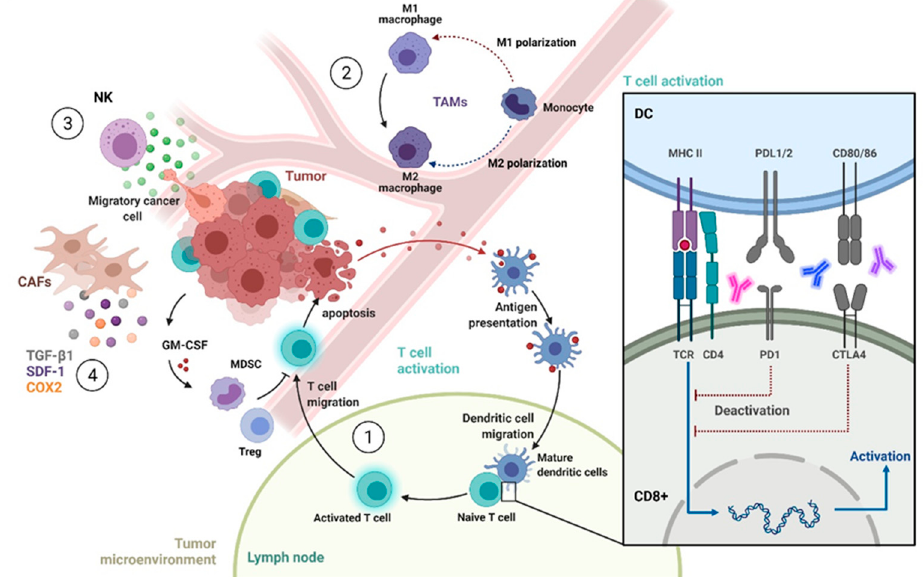
Figure 4. Tumor microenvironment in cervical cancer (1). Immune cells, endothelial cells, fibroblasts, signaling proteins and extracellular matrix molecules within the tumor TME and in lymph nodes impact on tumor biology, therapy response and survival. The adaptive antitumor immune response is mainly mediated by activated CD8+ T cells, while regulatory T cells (Tregs) and myeloid-derived suppressor cells suppress the immune response (2). Further, the polarization status of tumor associated macrophages (TAMs) impact on treatment response and survival, while natural killer (NK) cell activity is modulated and hindered by HPV+ tumor cells (3). Moreover, cancer-associated fibrob- lasts (CAFs) promote apoptotic resistance, proliferation, angiogenesis, inflammation, invasion and metastatic spread of cancer cells in a paracrine manner (4). Details are given in the text. Abbreviations: CTLA4: cytotoxic T-lymphocyte-associated protein 4; COX2: cyclooxygenase 2; GM-CSF: granulocyte macrophage colony-stimulating factor; PD1: programmed death 1; SDF-1: stromal cell-derived factor 1; TCR: T-cell receptor; TGF-ß1 transforming growth factor beta 1. Adapted from “T Cell Deactivation vs. Activation”, “Tumor-Specific T Cell Induction and Function” and “Cancer Cell Mutations Affect Tumor Microenvironment”, by BioRender.com (accessed on 2021). Retrieved from https://app.biorender.com/biorender-templates (accessed on October